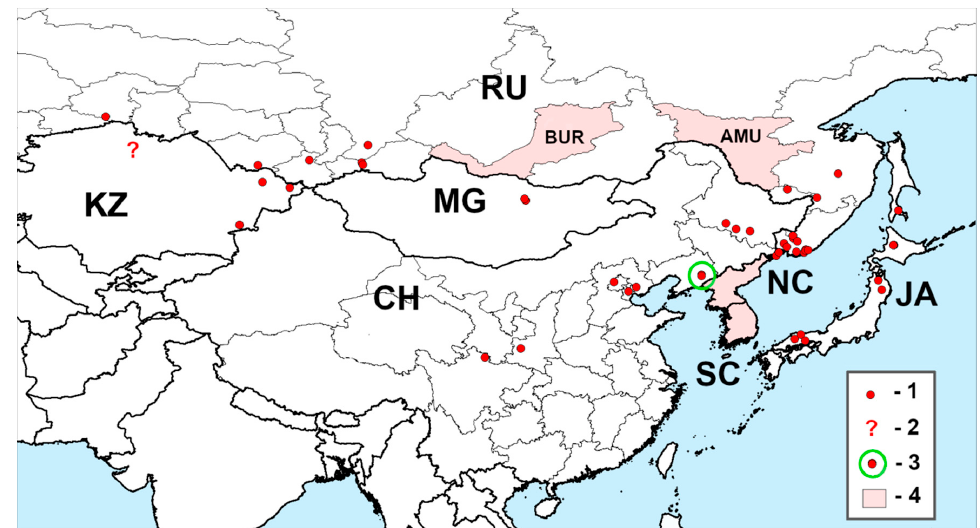
Figure 4. Range of Agrilus fleischeri Obenberger, 1925. 1—documented localities, 2—specimen with doubtful identification from North Kazakhstan, 3—outbreak site in Liaoning, 4—reported countries and administrative units for which exact localities were not found. CH—China, JA—Japan, KZ—Kazakhstan,